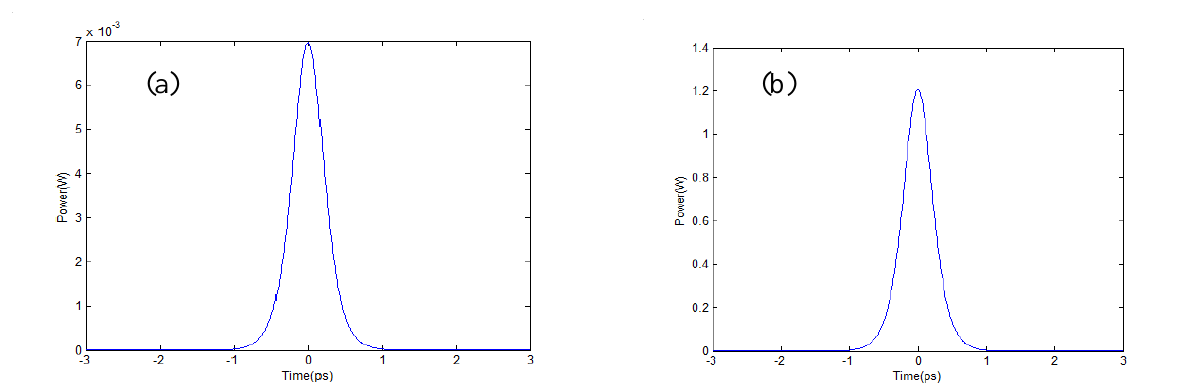
Fig.6: Soliton growth from spontaneous emission with EDFL parameters are γ=0.012(Wm) -1 , β =-.012ps 2 /m, α =0.3, T =0.047ps,α=0.17822771m -1 , =0.7827525m 1- , , . 2 2 2